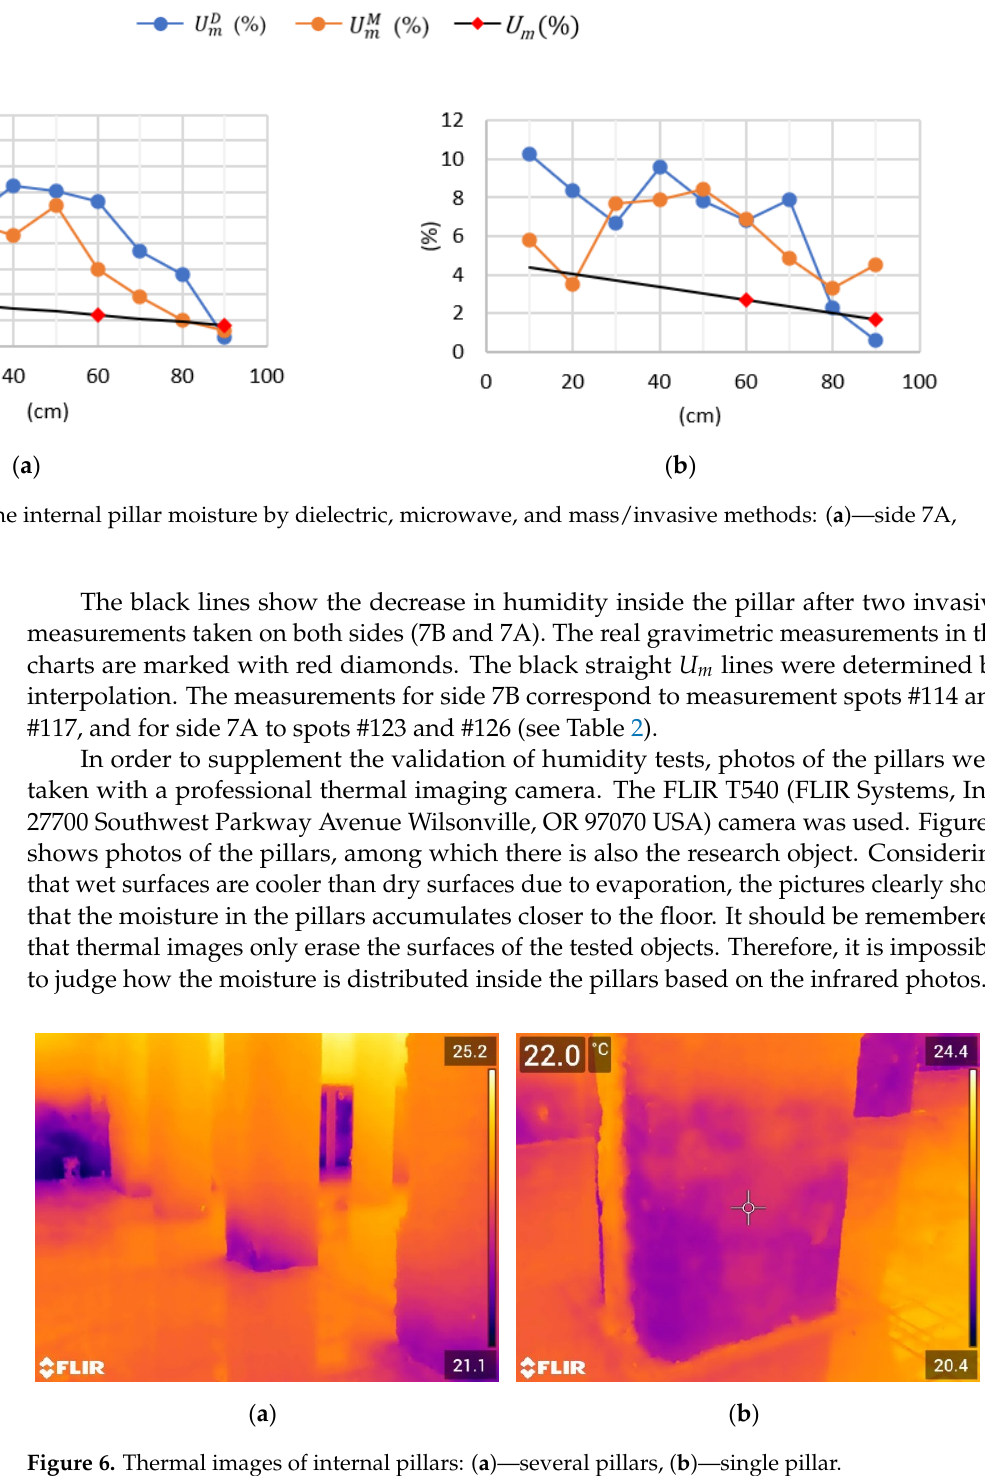
(cm) Figure 7. Model of the multiple EIT system converting electrical signals into 3D image pixel-by- pixel. 2.3.1. Gauss–Newton (GN)